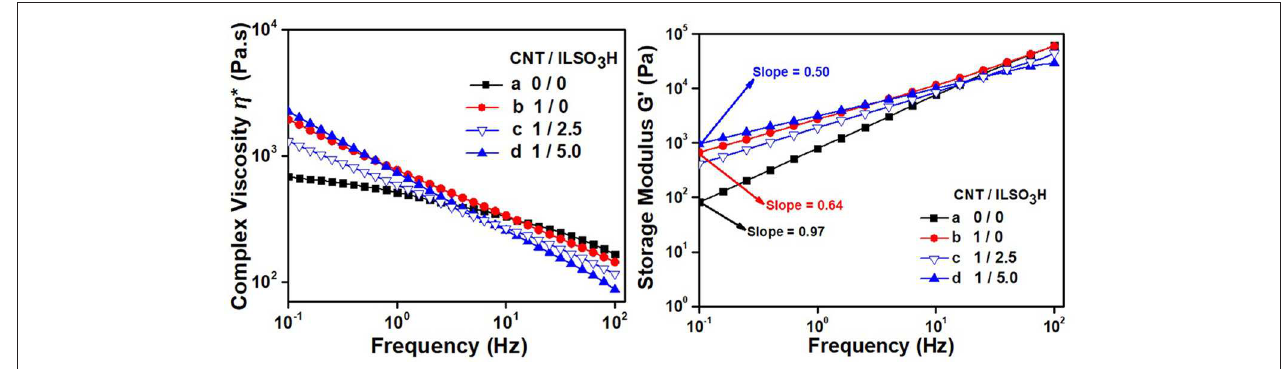
FIGURE 3 | Rheological parameters of PLA/EVA containing CNT/ILSO 3 H in a proportion of (a) 0:0; (b) 1:0; (c) 1:2.5; and (d) 1:5 phr.